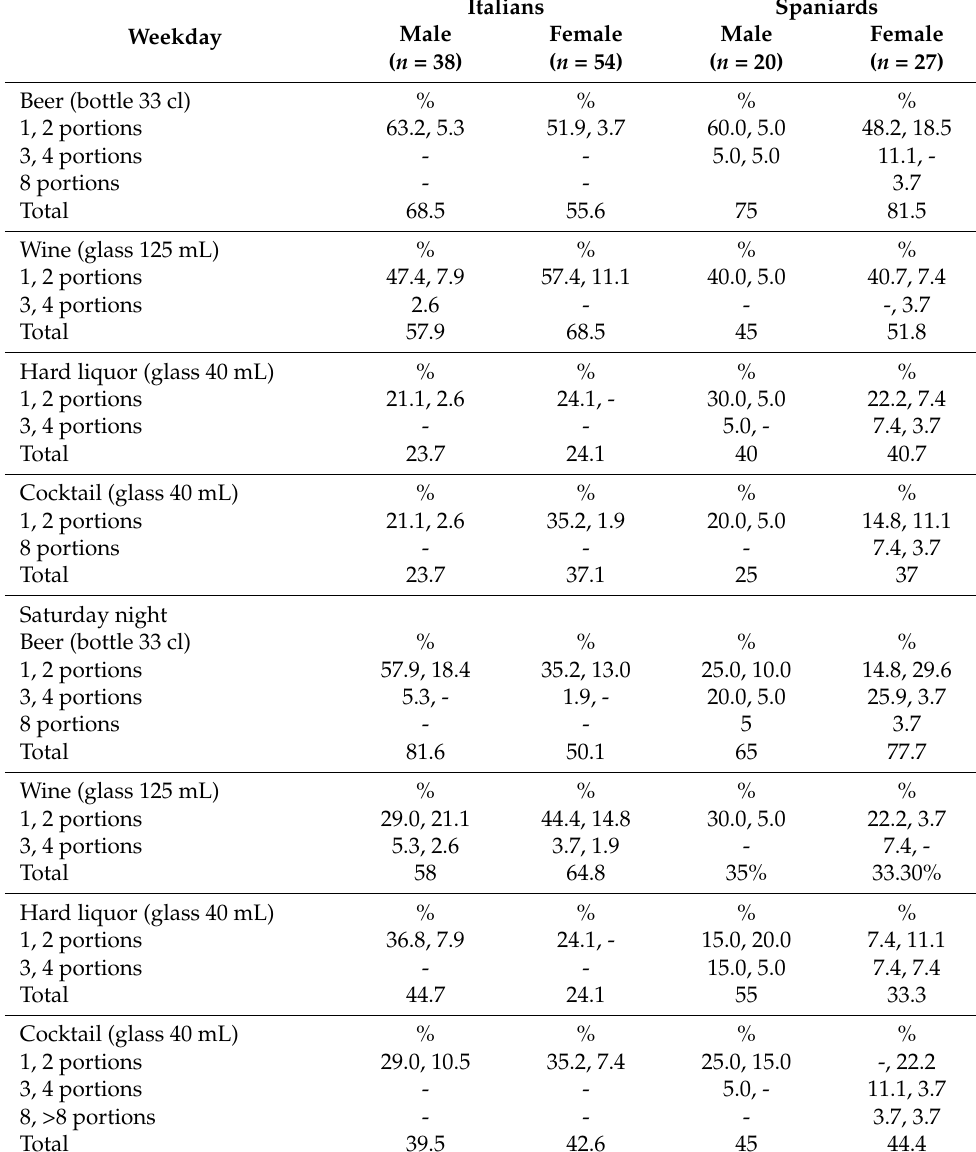
Table 2. Percentages of drinkers for different alcoholic